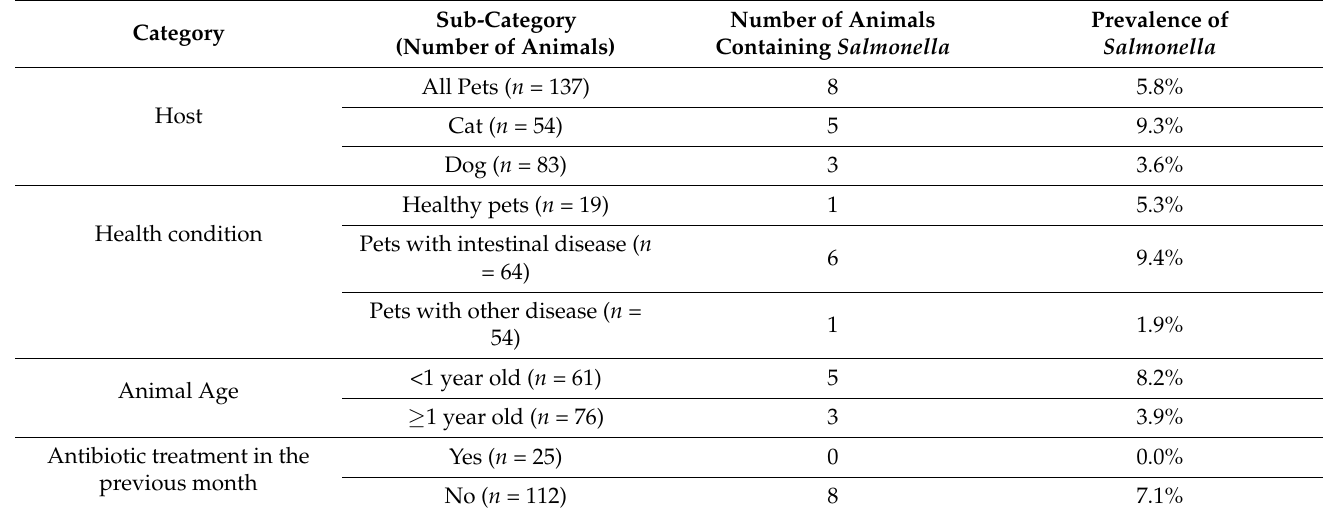
Table 1. Prevalence of Salmonella in distinct pet